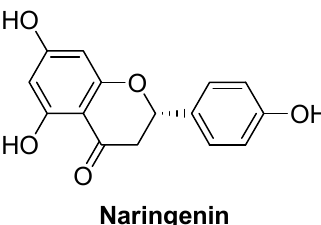
Figure 35. Naringenin.